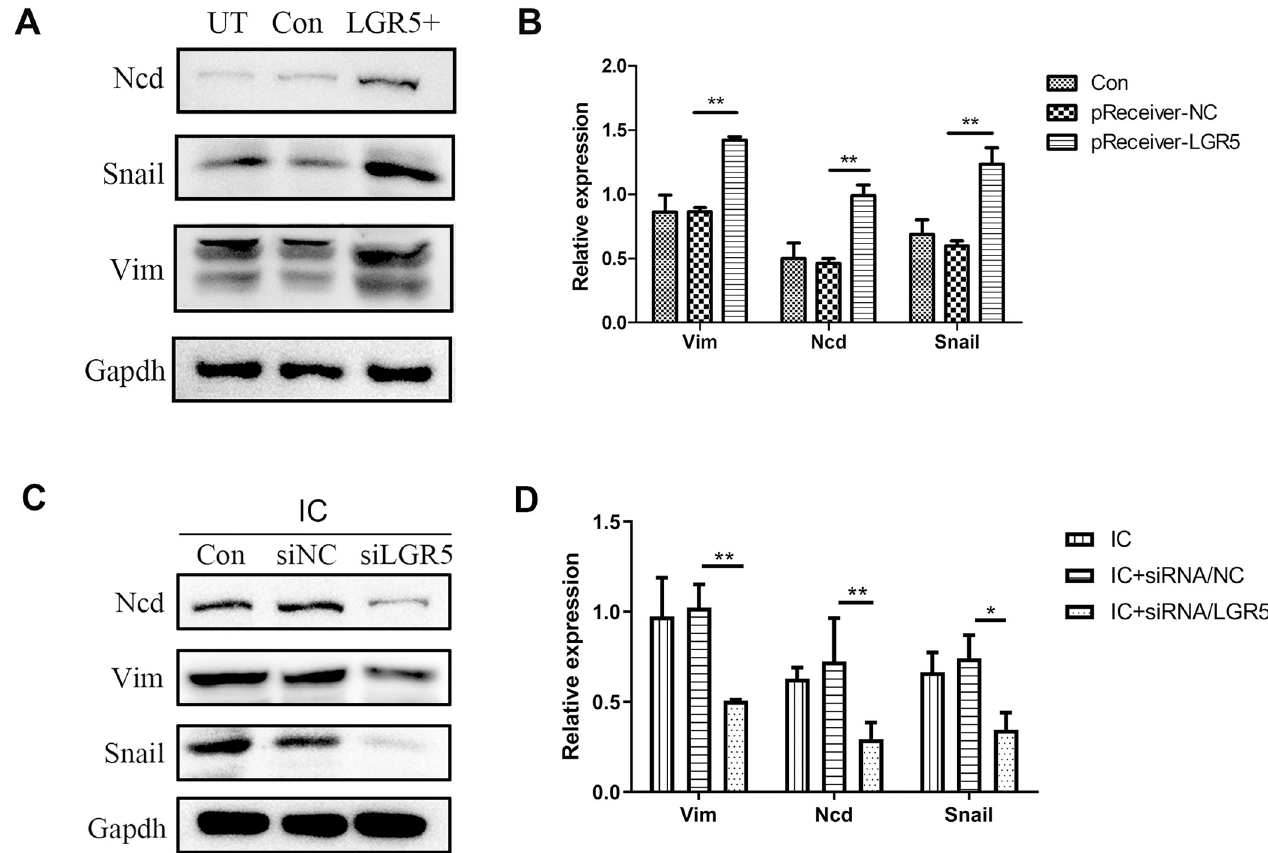
Fig 3. Expression levels of EMT-related genes. A-B: Protein levels of EMT-related genes vimentin, NCD, and snail were determined by immunoblotting illustrating higher protein levels of them in FaDu/LGR5+ cells. GAPDH served as loading control. Quantification (B) and representative blots (A) are shown. C-D: FaDu cells with IC stimulation were transfected with LGR5 siRNA or siRNA NC. Western blotting was used to examine the levels of vimentin, NCD, and snail expression. When LGR5 was silenced with siRNA, the expression of vimentin, NCD, and snail was also decreased. Quantification (D) and representative blots (C) are shown. Statistical significance is denoted by � P < 0.05, �� P < 0.01. UT: untreated group; IC: inflammatory condition; siNC: negative control siRNA; siLGR5: LGR5 siRNA.